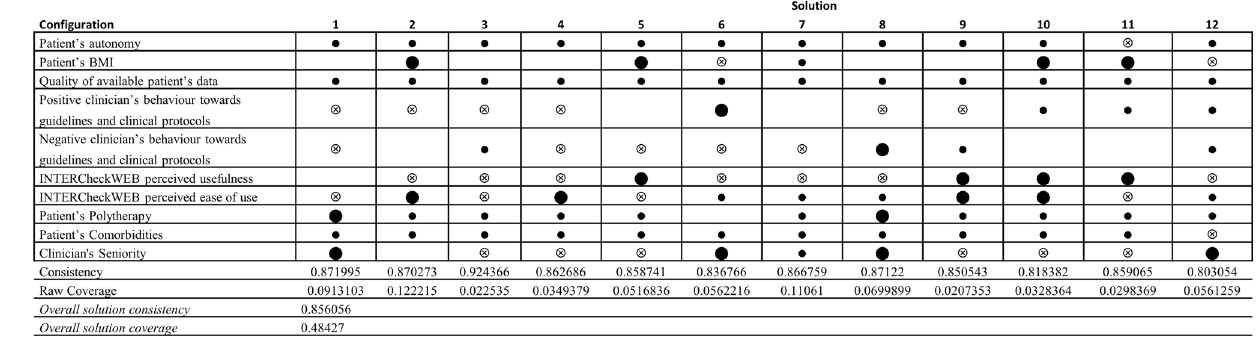
Figure 2. The consistent and empirically relevant